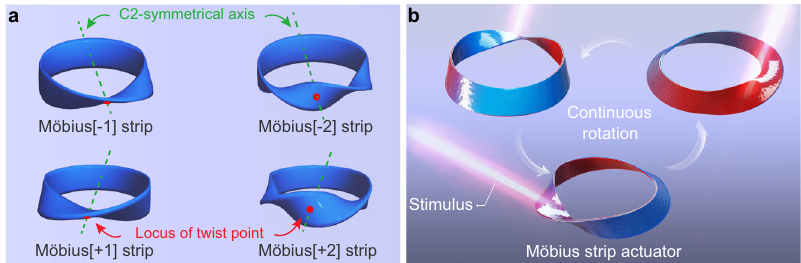
Fig. 1 A stimulus-guided continuous rotating Möbius strip actuator. a Schematic illustration of the C2 symmetry axis and locus of twist point of Möbius [±1] and Möbius[±2] strip models. Möbius[± T w ] strip de fi nes all the Möbius and twisted toroidal ribbons. T w is de fi ned as the number of 180° rotations, T = 1 or 2; the positive or negative sign corresponds to a left-handed or right-handed helix. b Diagrammatic drawing of the desired in situ continuous w rotation scenario of the Möbius strip actuator under an external stimulus. The colour gradient from red to blue represents the contraction capability gradient (the red and blue parts indicate high and low contraction capabilities,